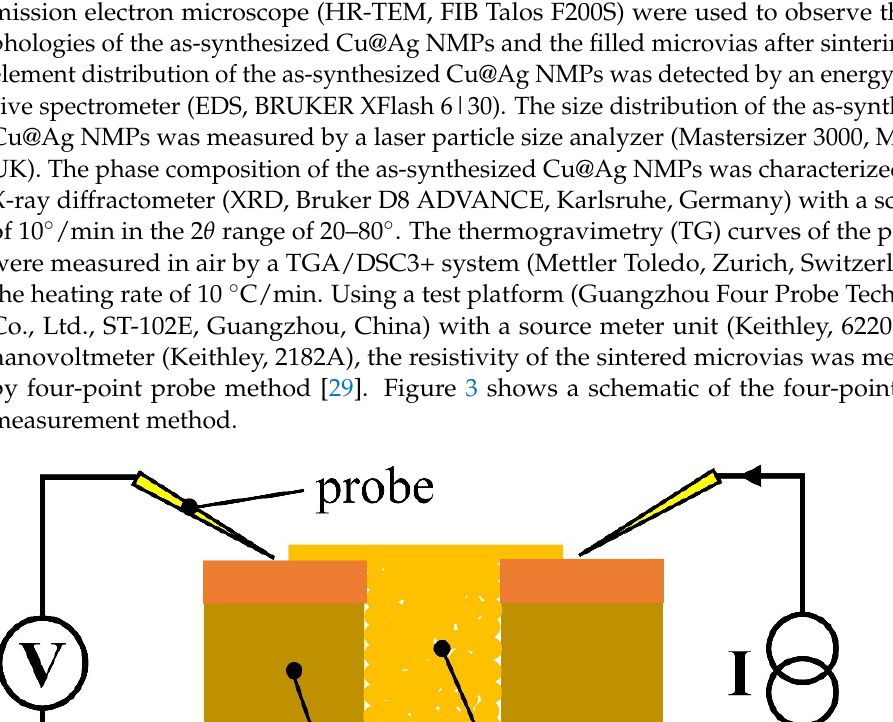
Figure 2. A typical temperature curve during the sintering process.